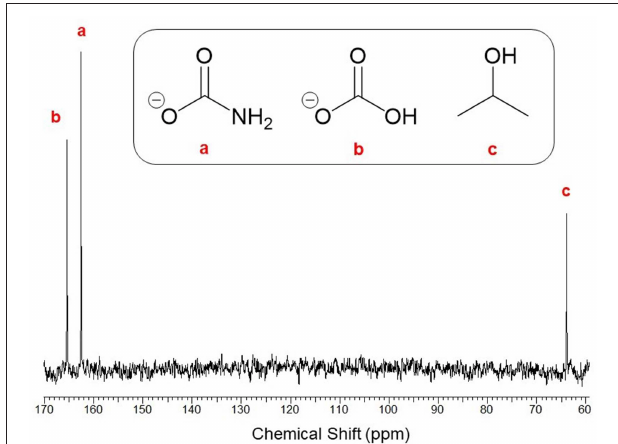
FIGURE 5 | 13 C-NMR (400 MHz, D 2 O) spectrum of the isolated solids with respective assignments of (a) ammonium carbamate [ δ = 162.4], (b) ammonium (bi)carbonate [ δ = 165.6], and (c) residual i- PrOH solvent [ δ =